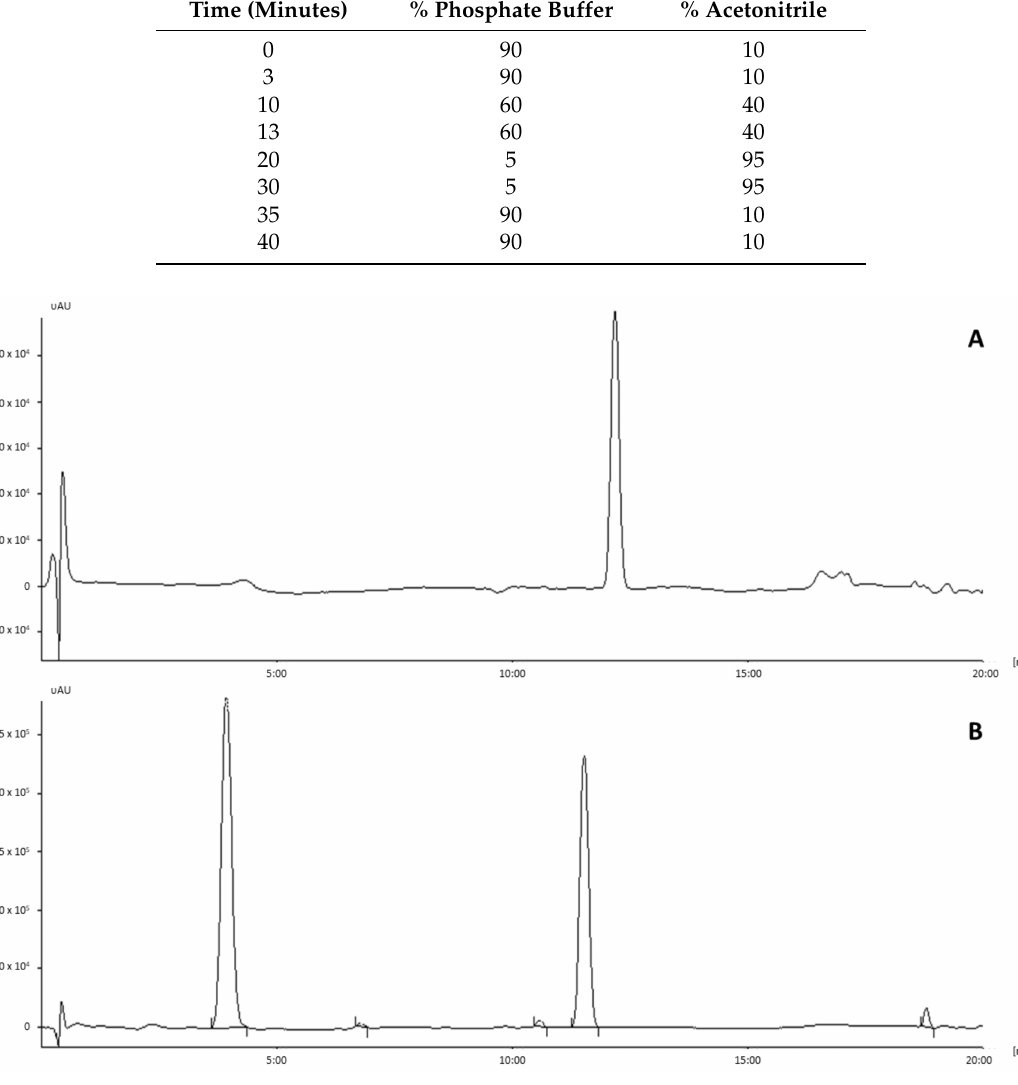
Figure A2. ( A ) Compound 1b (RT: 12 min); ( B ) reaction mixture (MW) acetophenone (2.0 eq.), N -benzylmethylamine hydrochloride (1 eq.), paraformaldehyde (1